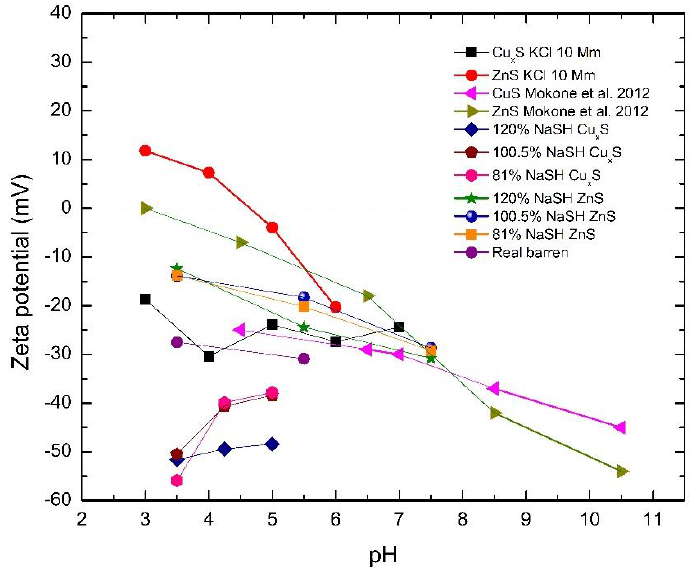
Figure 6. Zeta potential values obtained by Gim-Krumm and coleagues [49] for Cu x S and ZnS, compared to previous results by Mokone and colleagues [86]. Adapted from [49].